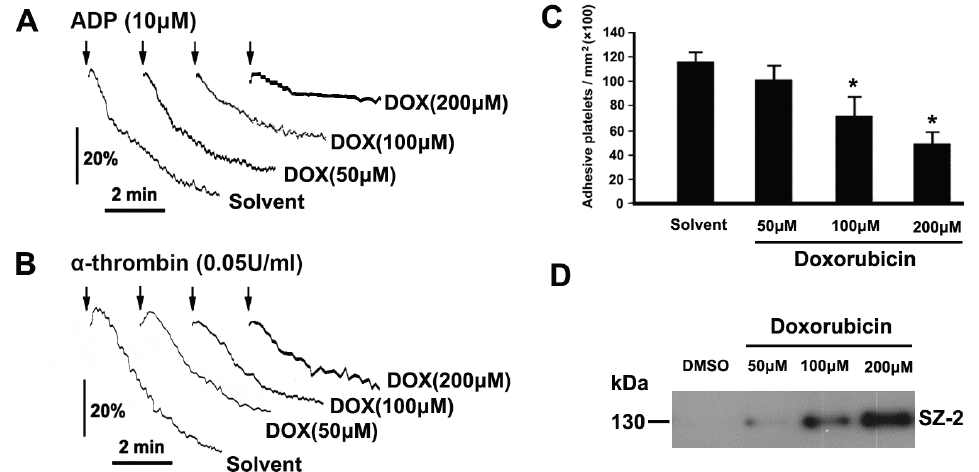
Figure 3. DOX impaired platelet function. ( A , B ) PRP or washed platelets were incubated with different concentrations of DOX or solvent. Platelet aggregation was induced